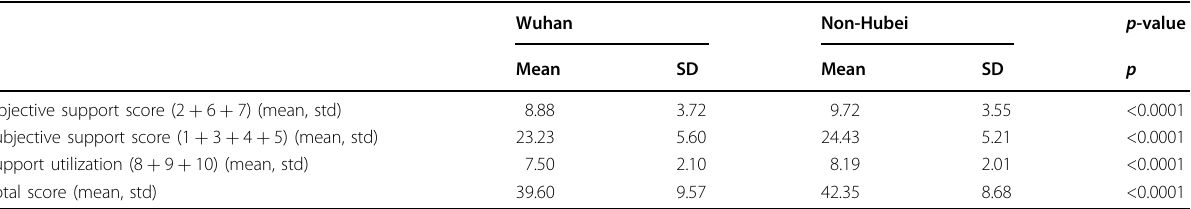
Table 6 Outcomes of SSRS for